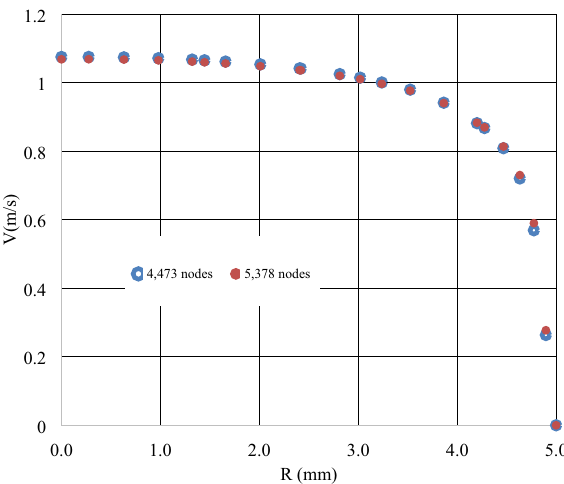
Figure 1. Velocity profile of the Cu/water nanofluid inside the pipe.